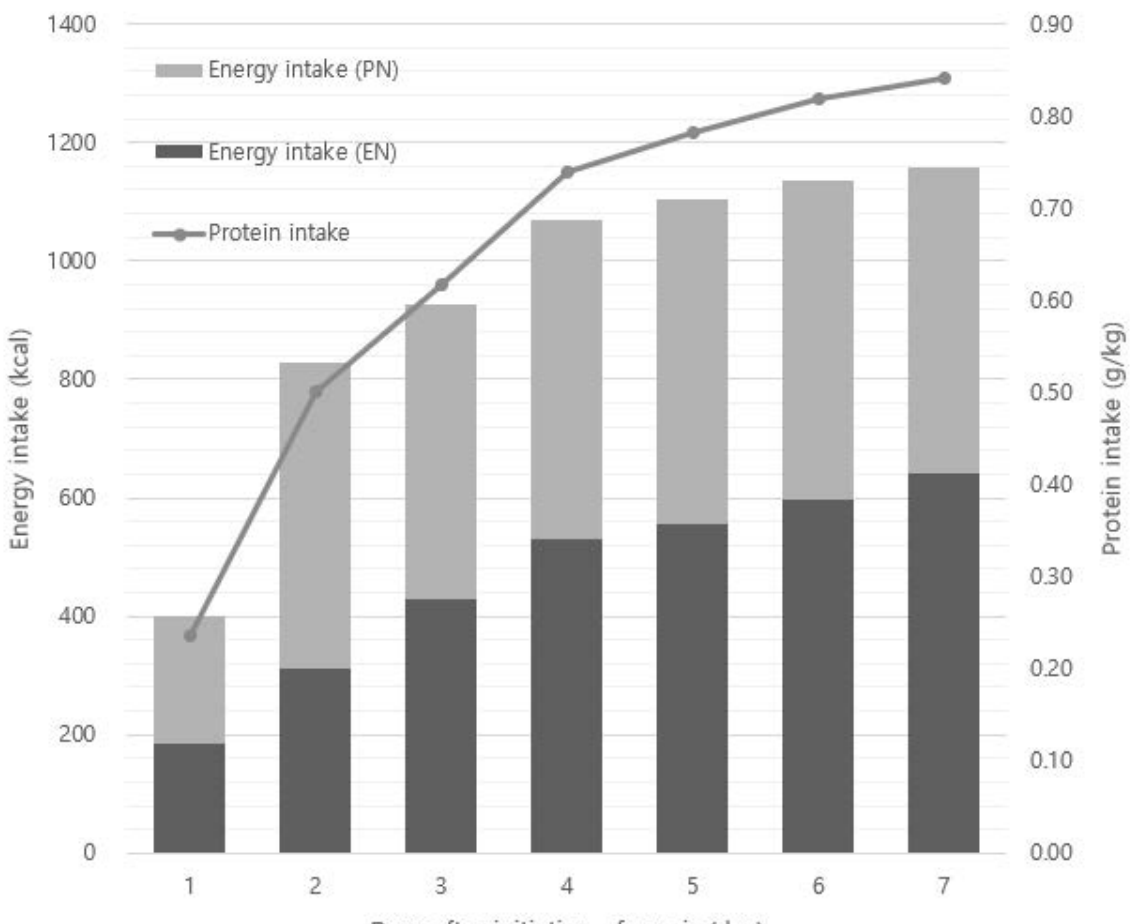
Figure 2. Daily energy (kcal) and protein (g/kg) received by patients following sepsis and septic shock onset. Column height represents the mean daily energy received (kcal). PN is the light grey and EN is the dark grey parts of the columns. Gray dots and lines represent protein intake (g/kg). EN, enteral nutrition; PN, parenteral